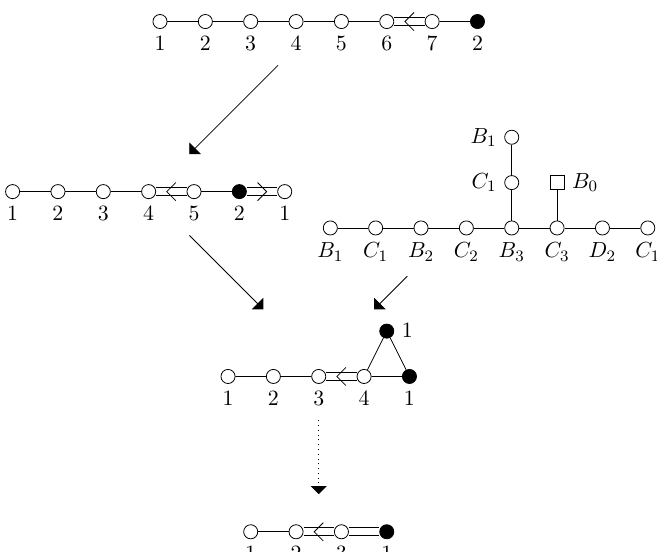
Figure 6 . The sp (14)